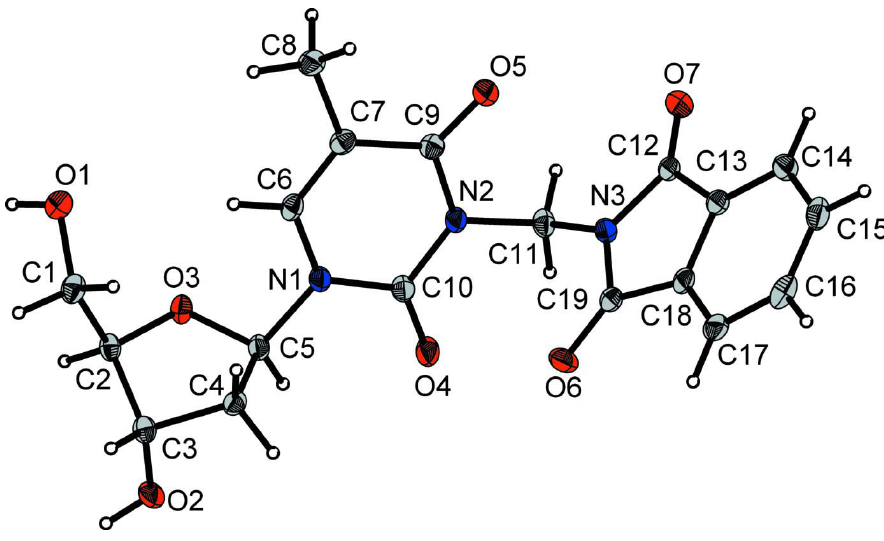
Figure 1 View of the title structure, with the atom numbering scheme and the displacement ellipsoids drawn at 50% probability